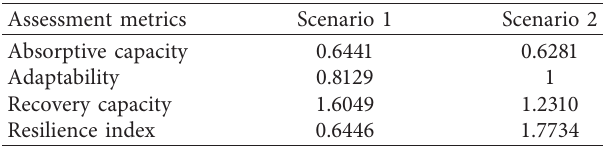
Table 2: Resilience assessment results of CBTC systems under two